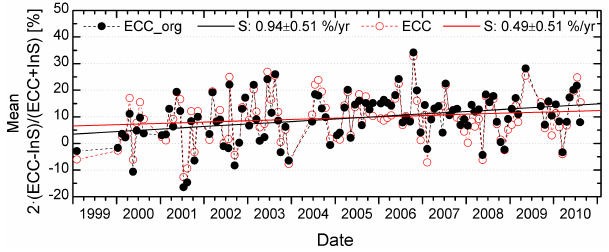
Fig. 8. Monthly mean time series of the relative differences [%] be- tween the ozone VMR from the ECC sonde data (corrected, ECC, and not corrected by the daily CF, ECC org,) at Iza˜na’s altitude and surface data ( N = 112). The solid lines are the linear regression lines of the least square fits. The slopes and the 95% confidence ranges ( ± 2 σ ) are shown in the legend ( S